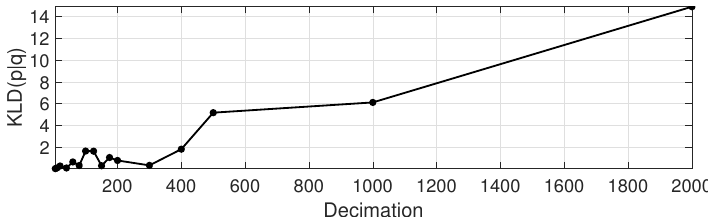
Figure 3. Kullback–Leibler divergence (KLD) between the original and decimated version of the proposed likelihood model for point cloud observations. Note that the decimated versions are remarkably similar to the original one up to decimation ratios of roughly ∼